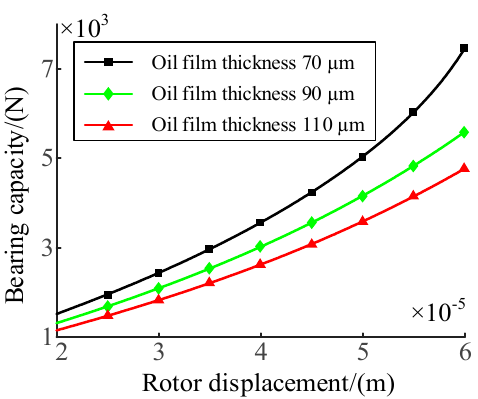
Figure 8. Relationship curve between bearing capacity and rotor displacement under different oil film thickness.